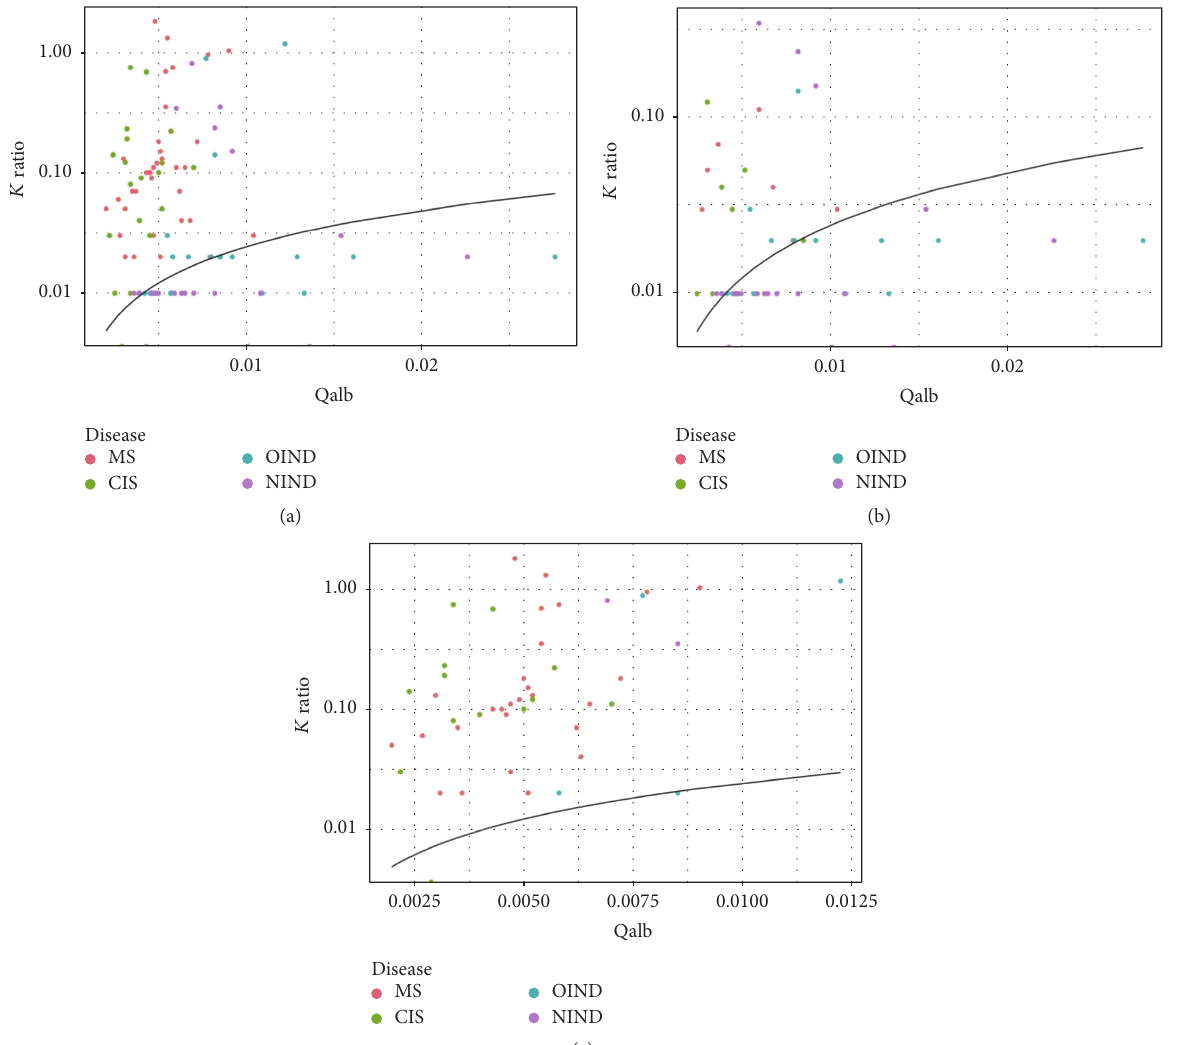
Figure 3: KFLC threshold line (at KFLC index 2.43) in half-logarithmic diagram with results of MS, CIS, OIND, and NIND patients (a), OCB negative patients (b), and OCB positive patients (c). CIS: clinically isolated syndrome; MS: multiple sclerosis; OIND: other inflammatory neurological disease; NIND: noninflammatory neurological disease; KFLC: kappa free light chain; OCB: oligoclonal bands.